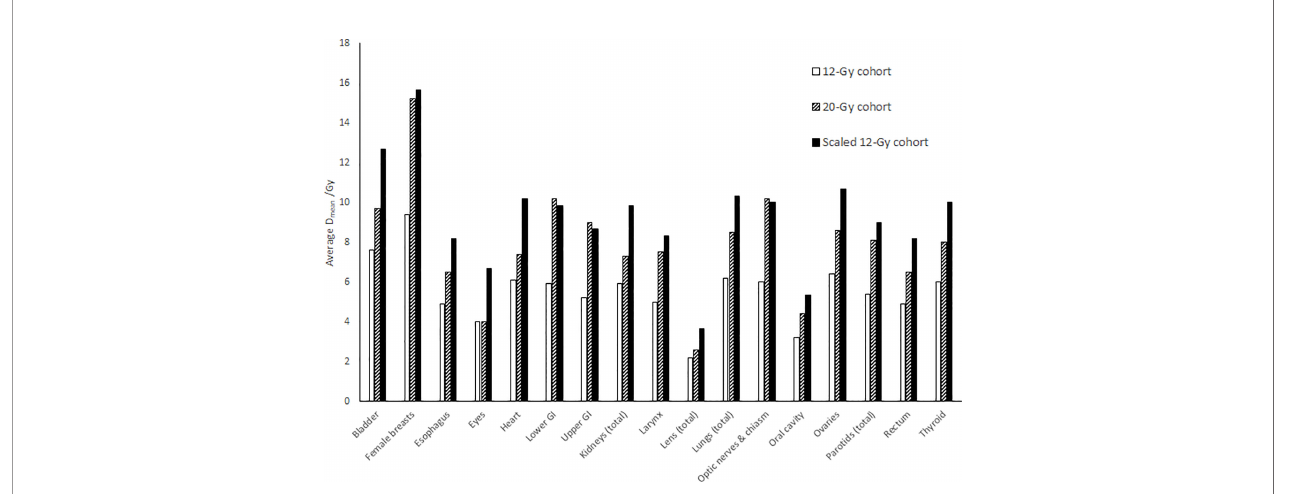
FIGURE 4 | Comparison of average mean dose (D mean ) to each normal organ between the 12-Gy cohort and the 20-Gy cohort. The “ Scaled 12-Gy cohort ” data series shows average D mean for the 12-Gy cohort scaled by the prescription dose ratio